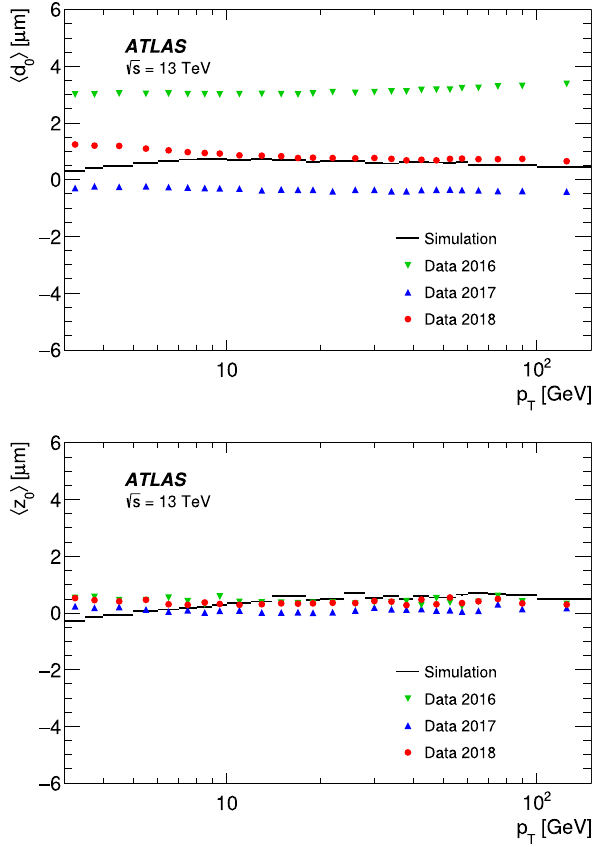
Fig. 26 The transverse (left) and longitudinal (right) impact parameter biases as function of the track η . The 2016 data entries in this figure are taken from the second part of the 2016 data visible in Fig. 24; the first part of 2016 data also shows no impact parameter dependence on track η rel have an RMS at the micrometer level while those in the endcap regions range from 2 µ m to O ( 10 µ